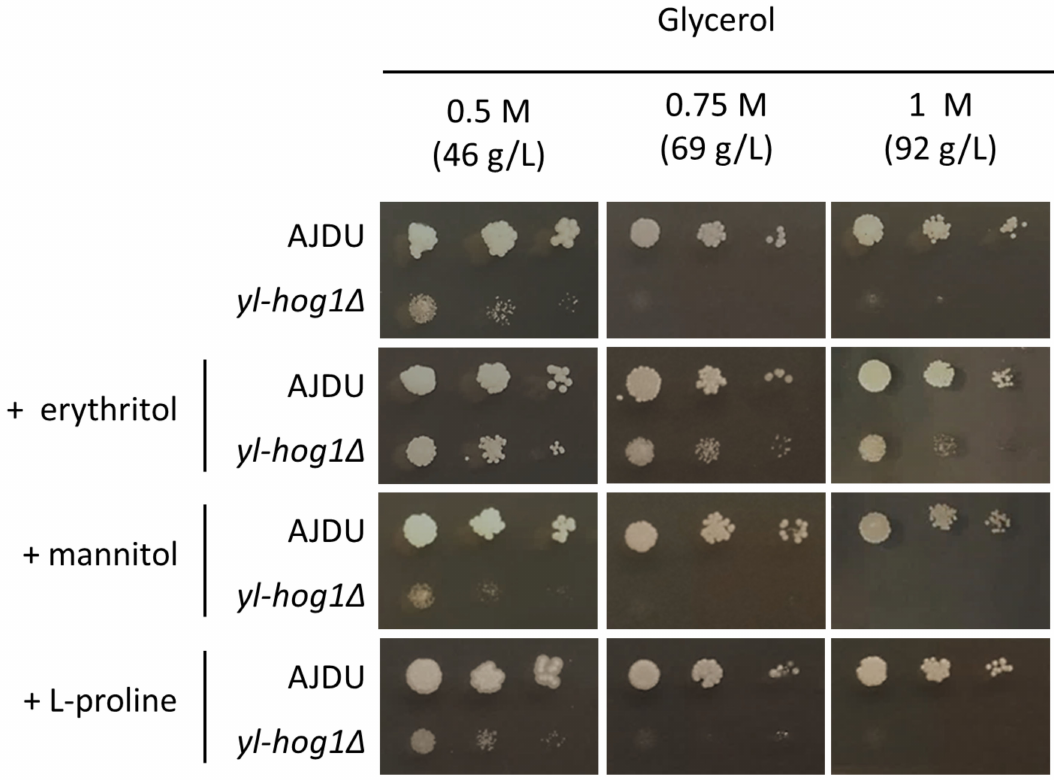
Figure 3. Growth of Y. lipolytica AJDU and yl-hog1 ∆ after 48 h of incubation on YNB agar plates with glycerol as the main carbon source. The additives tested for osmoprotective properties were 0.1 M erythritol, 0.1 M mannitol, and 0.02 M